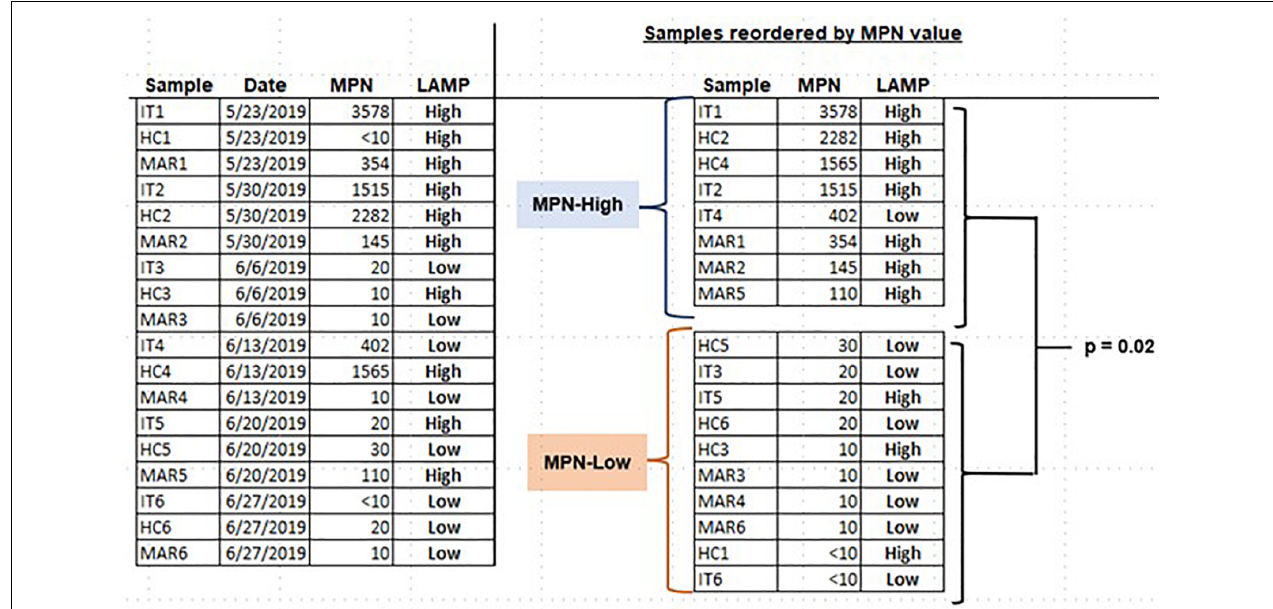
FIGURE 6 | Assessing Enterococcus spp. in water samples using LAMP. Water samples were collected at the indicated times from three different locations in the East River in New York City. Samples were tested for Enterococcus spp. both by Enterolert (IDEXX) and LAMP. LAMP results were made semi-quantitative by kinetic monitoring of SYBR Green fluorescence (see text). The association of high LAMP values with high MPN values was assessed by one-tailed Fisher’s exact test.